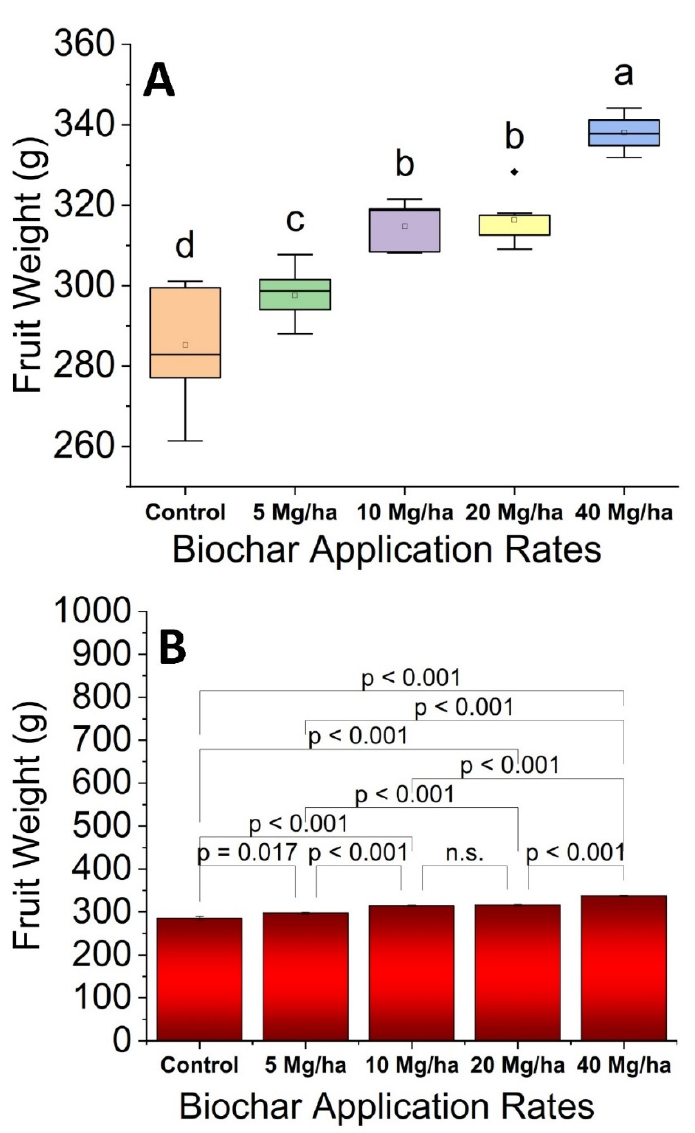
Figure 3. Effect of different biochar application rates on mango fruit weight. Bars are mean of 9 replicates. Different letters show a significant difference at p ≤ 0.05 ( A ). The probability value hierarchy for fruit weight is provided in ( B ).